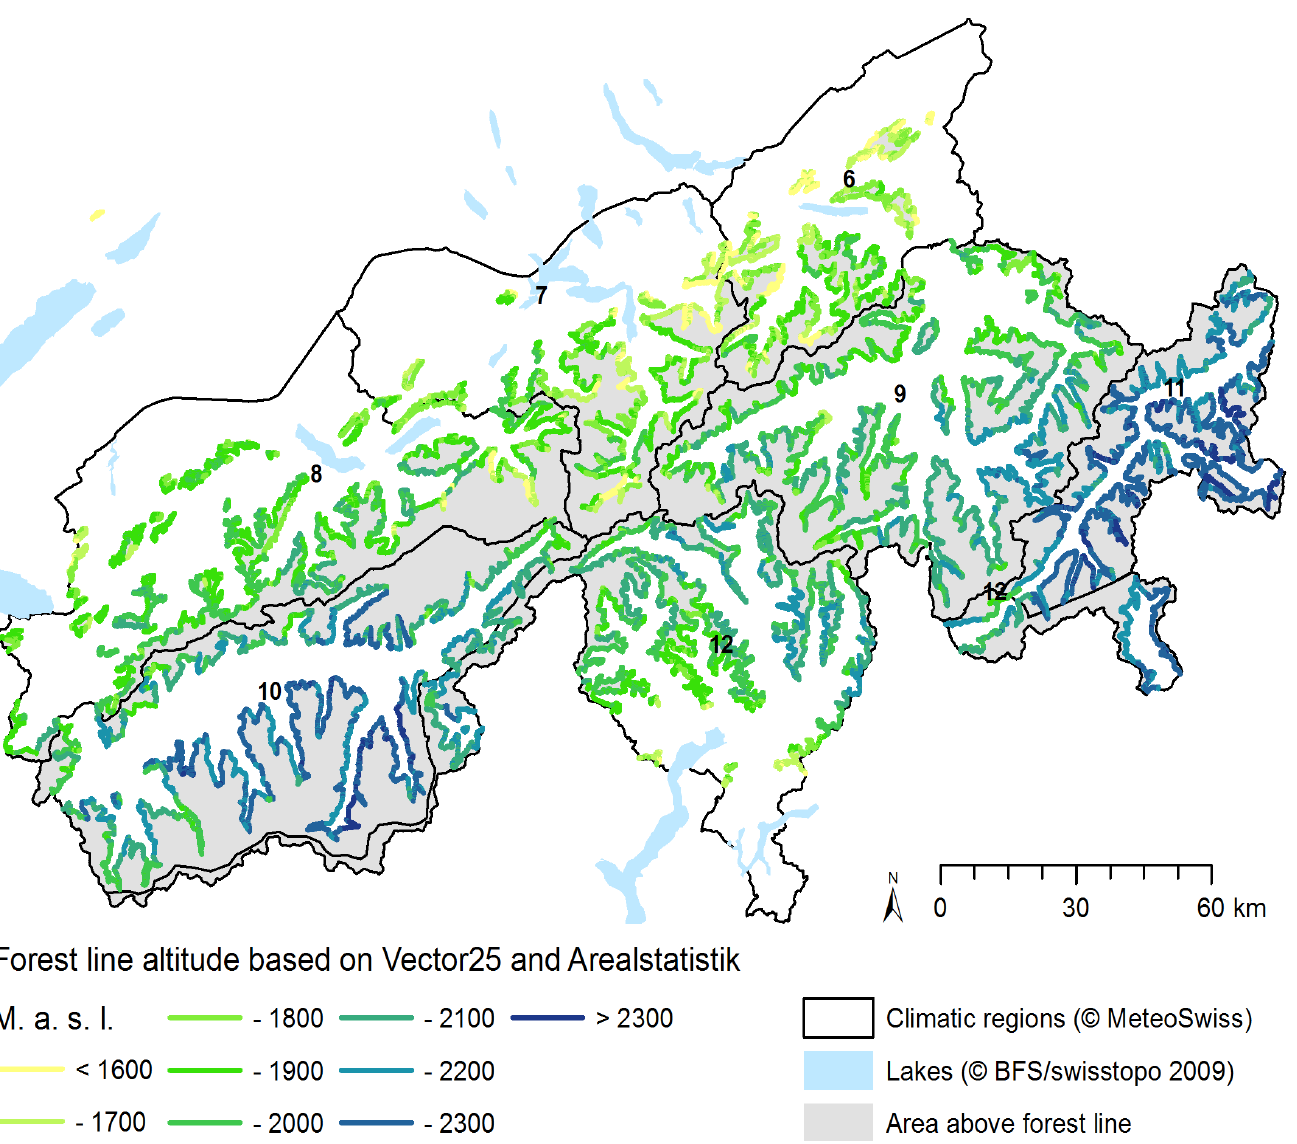
Figure 8: The forest line altitude is shown in categories. It rises from the isolated peaks and ridges to the shielded side valleys of the Valais (10) and the Engadin